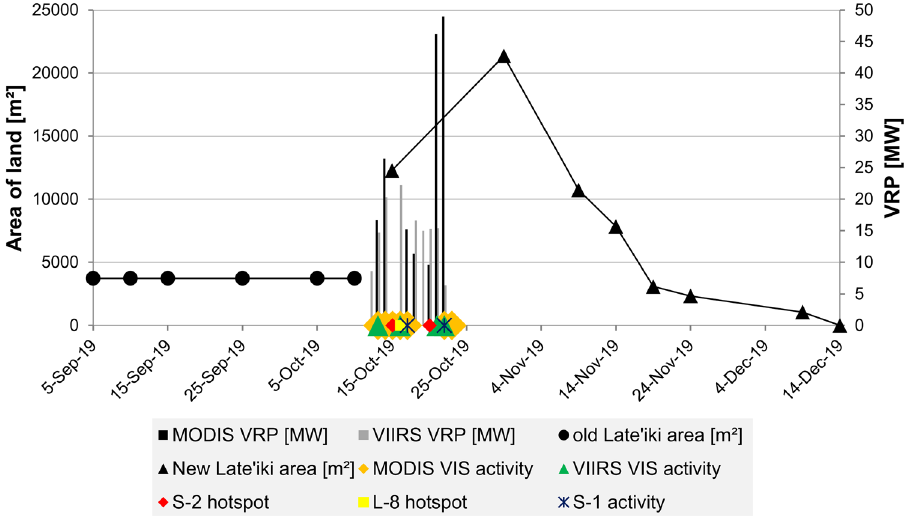
Figure 8. Joint analysis of (1) the spatio-temporal evolution of old Late’iki Island and New Late’iki Island as derived from Sentinel-2 imagery; (2) the VRP detected by MODIS and VIIRS during the eruption; (3) volcanic hotspots detected by Sentinel-2 and Landsat-8 using the NHI tool; (4) visible (VIS) volcanic activity as observed by MODIS and VIIRS RGB imagery as well as in Sentinel-1 SAR